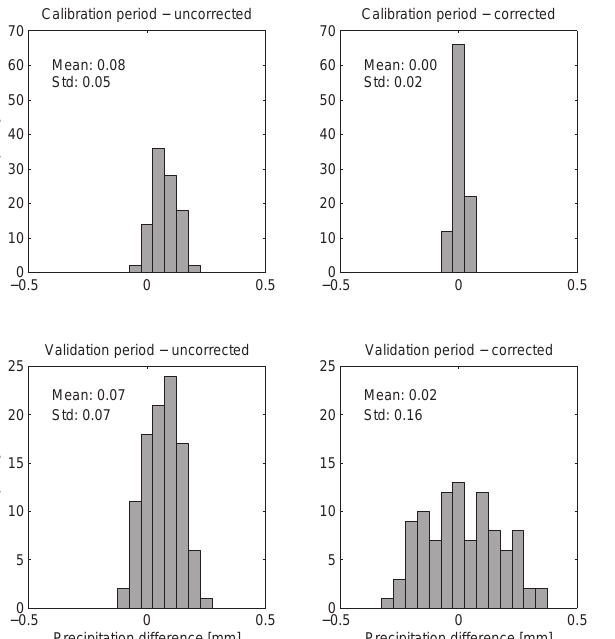
Fig. 19. Top: histograms of 100 samples of average daily temper- ature differences between the uncorrected and observed (left), and between the corrected and observed temperature (right) for the cal- ibration period. Bottom: similar, but for the validation